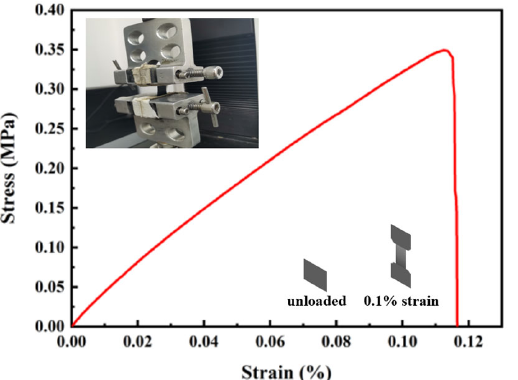
Figure 6. Stress–strain curve of MnFe 2 O 4 @chitosan/MWCNTs/PDMS biosensor.